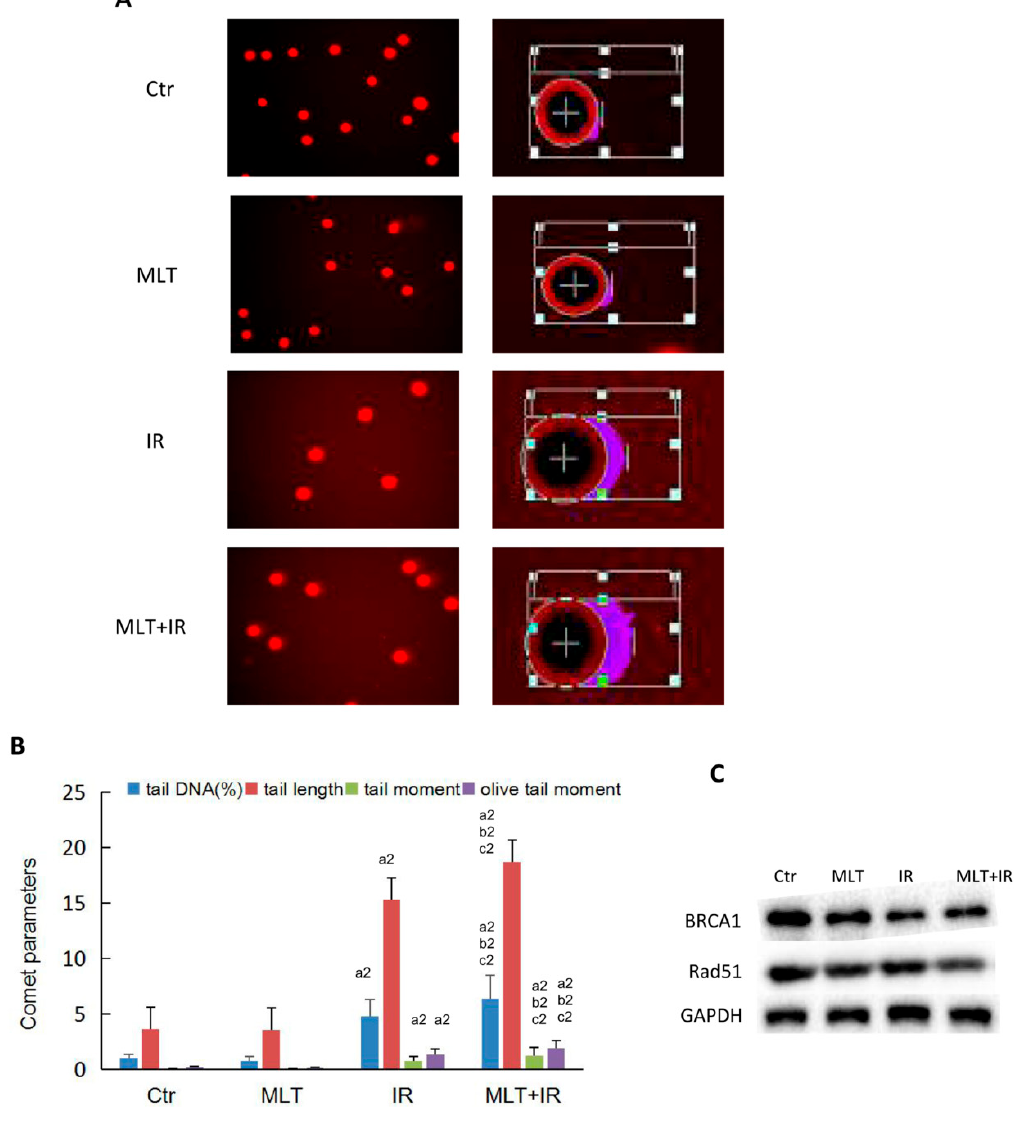
Figure 4. Melatonin accumulated DNA damage of HCT 116 cells exposed to γ -ray radiation. ( A ) HCT 116 cells were treated with or without 1 mM melatonin for 2 h, then exposed to 6 Gy γ -ray radiation or not. The comet assay was adopted to determine DNA damage after 2 h treatment. Representative images of comet assay in HCT 116 cells are displayed; ( B ) the DNA percentage in the comet tail (tail DNA %), tail length, tail moment, and olive tail moment representing the degree of DNA damage was calculated by analyzing 200 cells/sample; ( C ) total protein was extracted after 2 h treatment and the levels of proteins related with DNA damage and repair were detected by Western blot analysis. Data are presented as the mean ± SD. a2 p < 0.01 vs. control, b2 p < 0.01 vs. IR, c2 p < 0.01 vs. MLT.